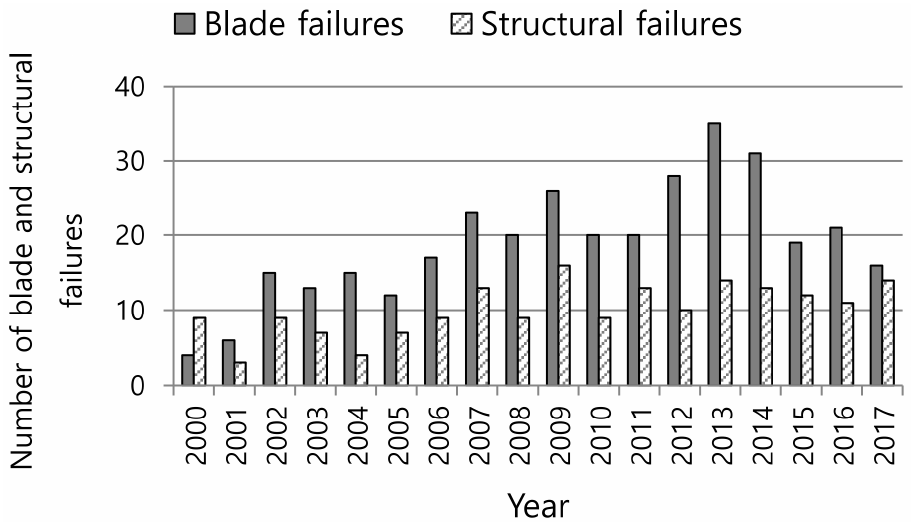
Figure 14. Annual data on blade and tower defects are compared [81].